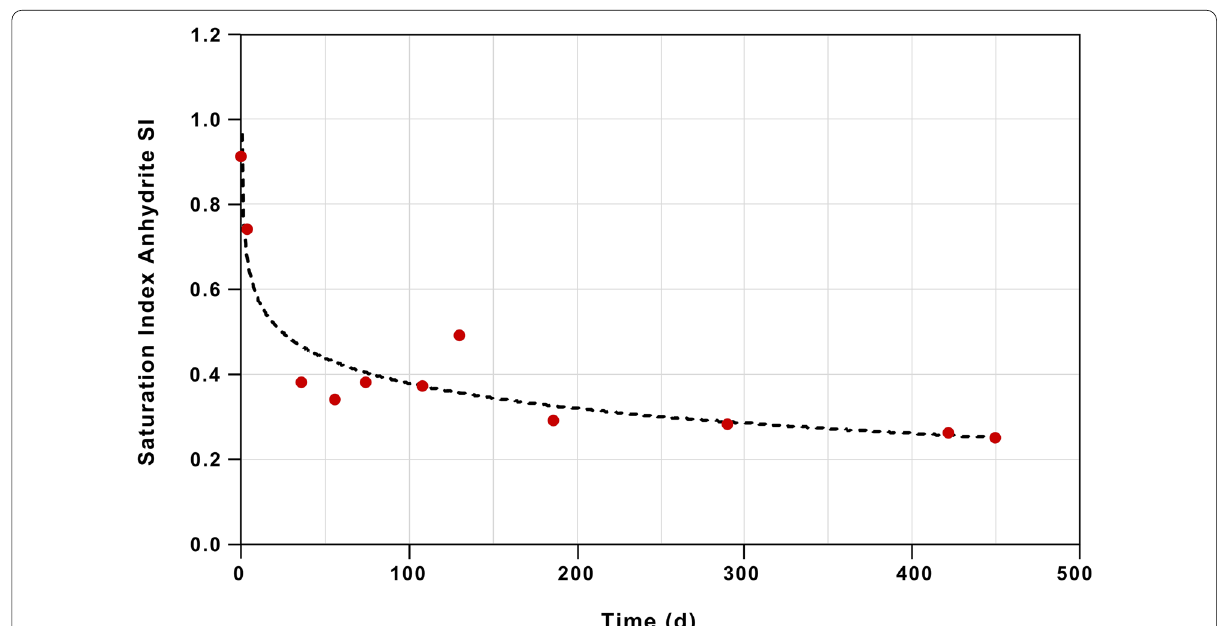
Fig. 9 Saturation state of the outflow water with respect to anhydrite at reservoir conditions (T